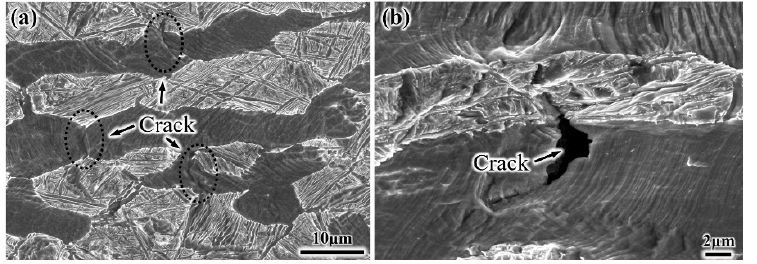
Figure 7. Microstructural characteristics of the EM under tensile deformation at different strain: ( a ) 6%, ( b ) 8.3%, ( c ) 12%, and ( d ) 14%. (The different equiaxed α p phases in the EM are marked with ① , ② , ③ , ④ , ⑤ and ⑥ ).